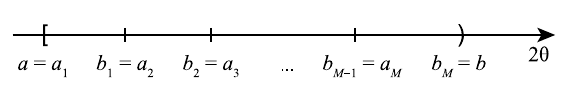
Figure 2: The partitioning of